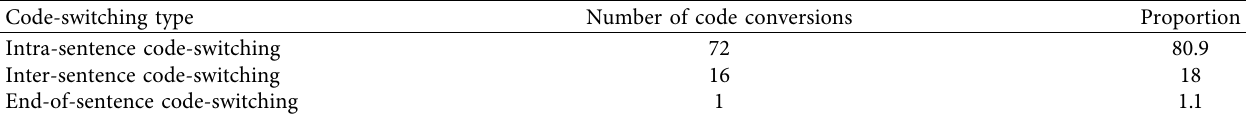
Table 2: Types of code conversion